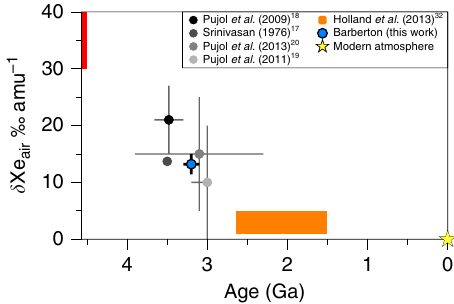
Figure 6 | Isotopic fractionation relative to the modern atmosphere of atmospheric Xe with time. Isotopic composition is expressed in per mil per atomic mass unit ( % u (cid:2) 1 ) relative to the modern atmosphere (yellow star). Data for fractionated Xe compositions from the literature are indicated by the solid black and grey circles (refs 17–20) and by the orange range 32 . Starting isotopic fractionation (red range) varies between 30 and 40 % u (cid:2) 1 depending if it is Solar (SW-Xe)/U-Xe or Chondritic (Q-Xe) (ref. 11). Data obtained in this study for Barberton samples are indicated with a solid blue circle and correspond to the isotopic fractionation computed with the Isoplot software taking the error-weighted average on all 27 measurements. Errors at 2 s for literature data and data from this work. No error is given for the fractionation described in ref. 17.